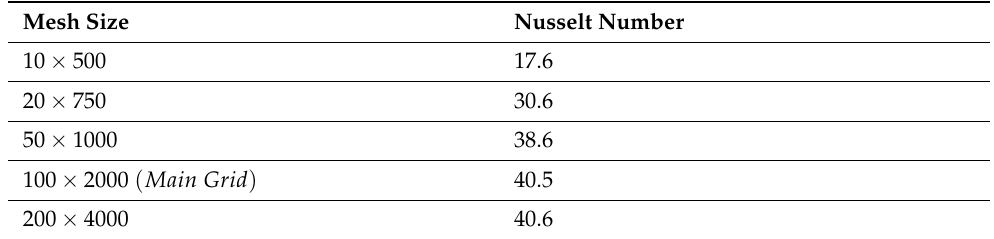
Figure 2. The mesh generated for the present work. Table 4. Mesh independence for the present study considering different mesh sizes at Re = 500. Mesh